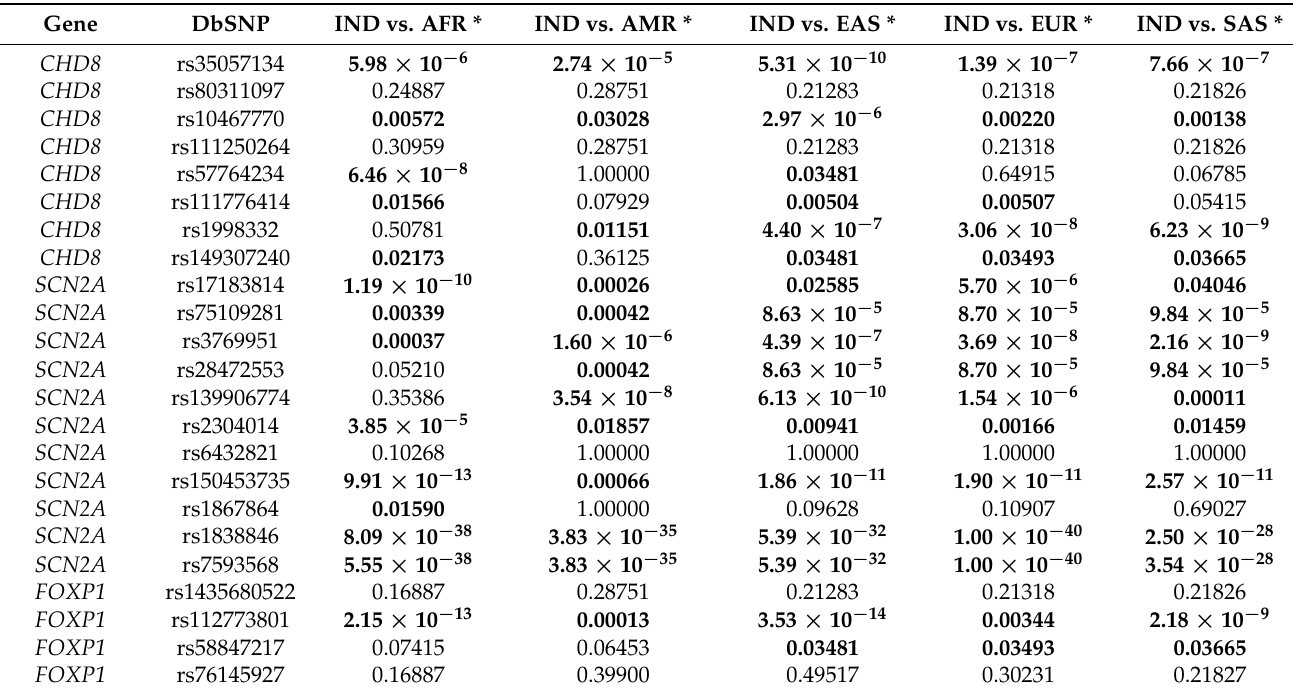
Table 2. Comparison between the allelic frequency of the Indigenous population and continental populations (African, American, East Asia, European, and South Asia) described in the database of 1000 Genomes